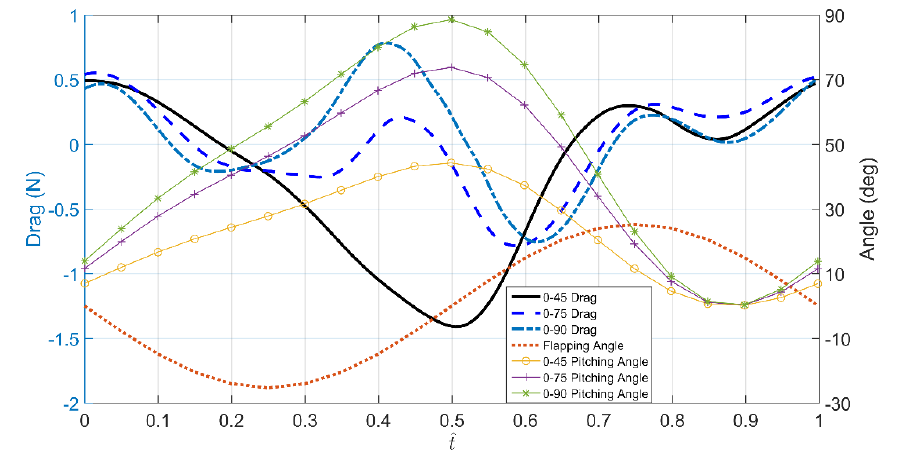
◦ ~45 ◦ , 0 ◦ ~75 ◦ , and 0 ◦ ~90 ◦